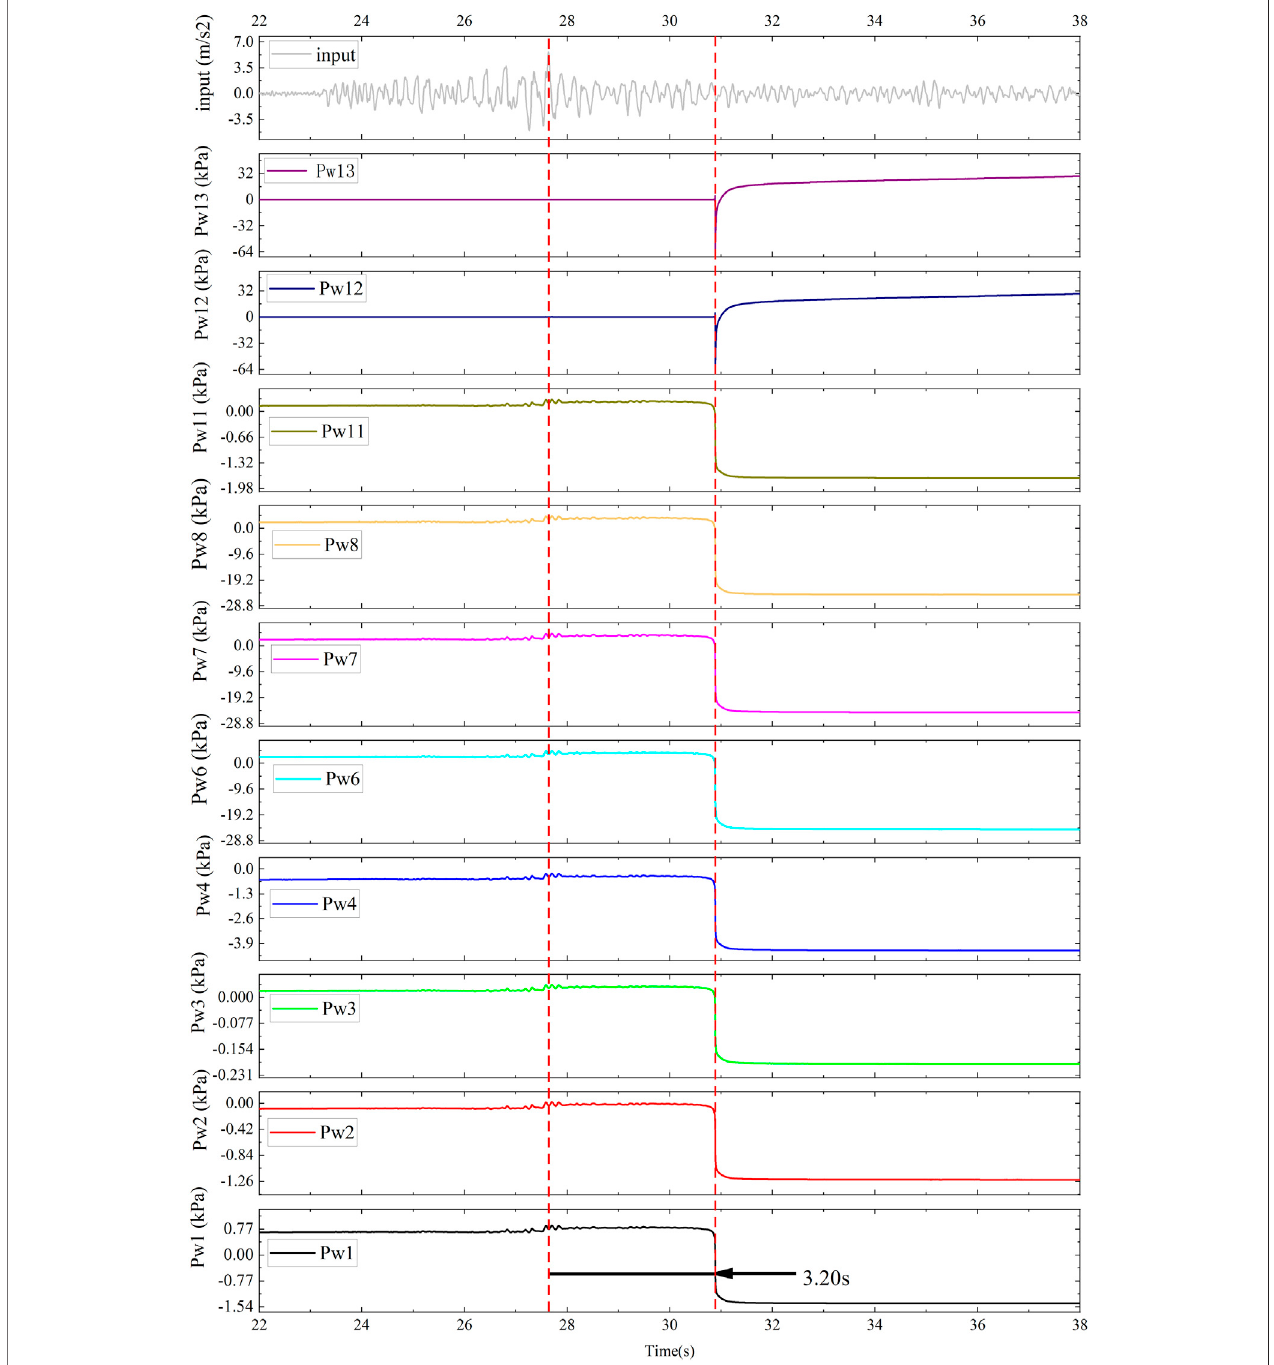
FIGURE 12 | Pore water pressure variation during high-intensity shaking (565